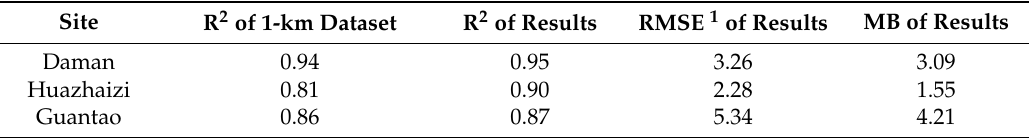
Table 6. Comparison of the 1-km dataset and the 30-m product with the in situ values. Site R 2 of 1-km Dataset R 2 of Results RMSE 1 of Results MB of Results Daman 0.94 0.95 3.26 3.09 Huazhaizi 0.81 0.90 2.28 1.55 Guantao 0.86 0.87 5.34 4.21 Note: 1 Root Mean Square